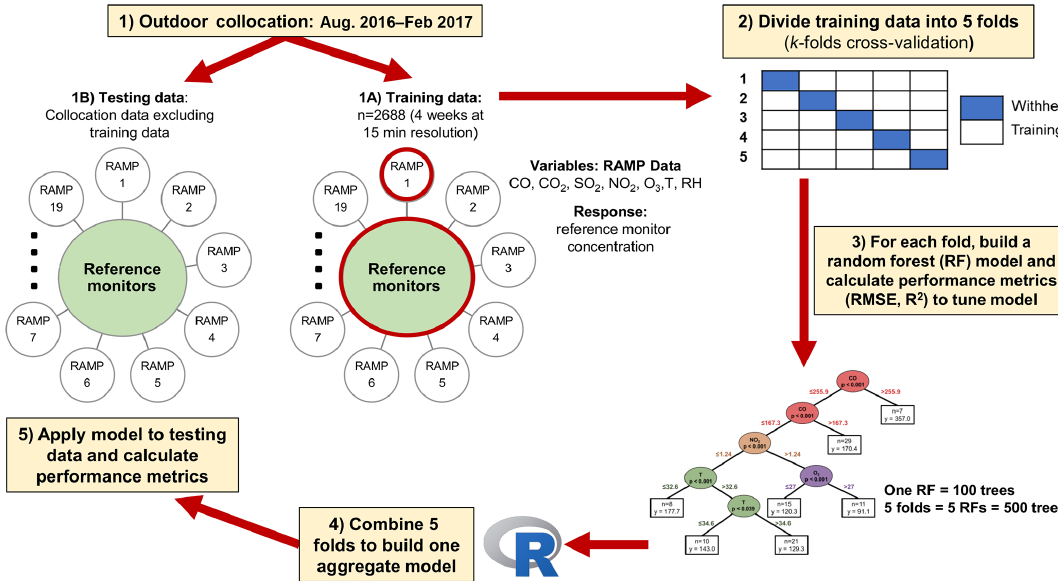
Figure 3. Flow path for data collection and RF model fitting and testing. From collocation period, 2688 points were sub-selected as training (1A) data, while the remaining data were used for model testing (1B). The training data were further divided into five cross-validation folds, and each fold was used to tune and build an RF model. All five models were then combined in R to build one cumulative model, and the predictive power of the model was assessed for the withheld testing